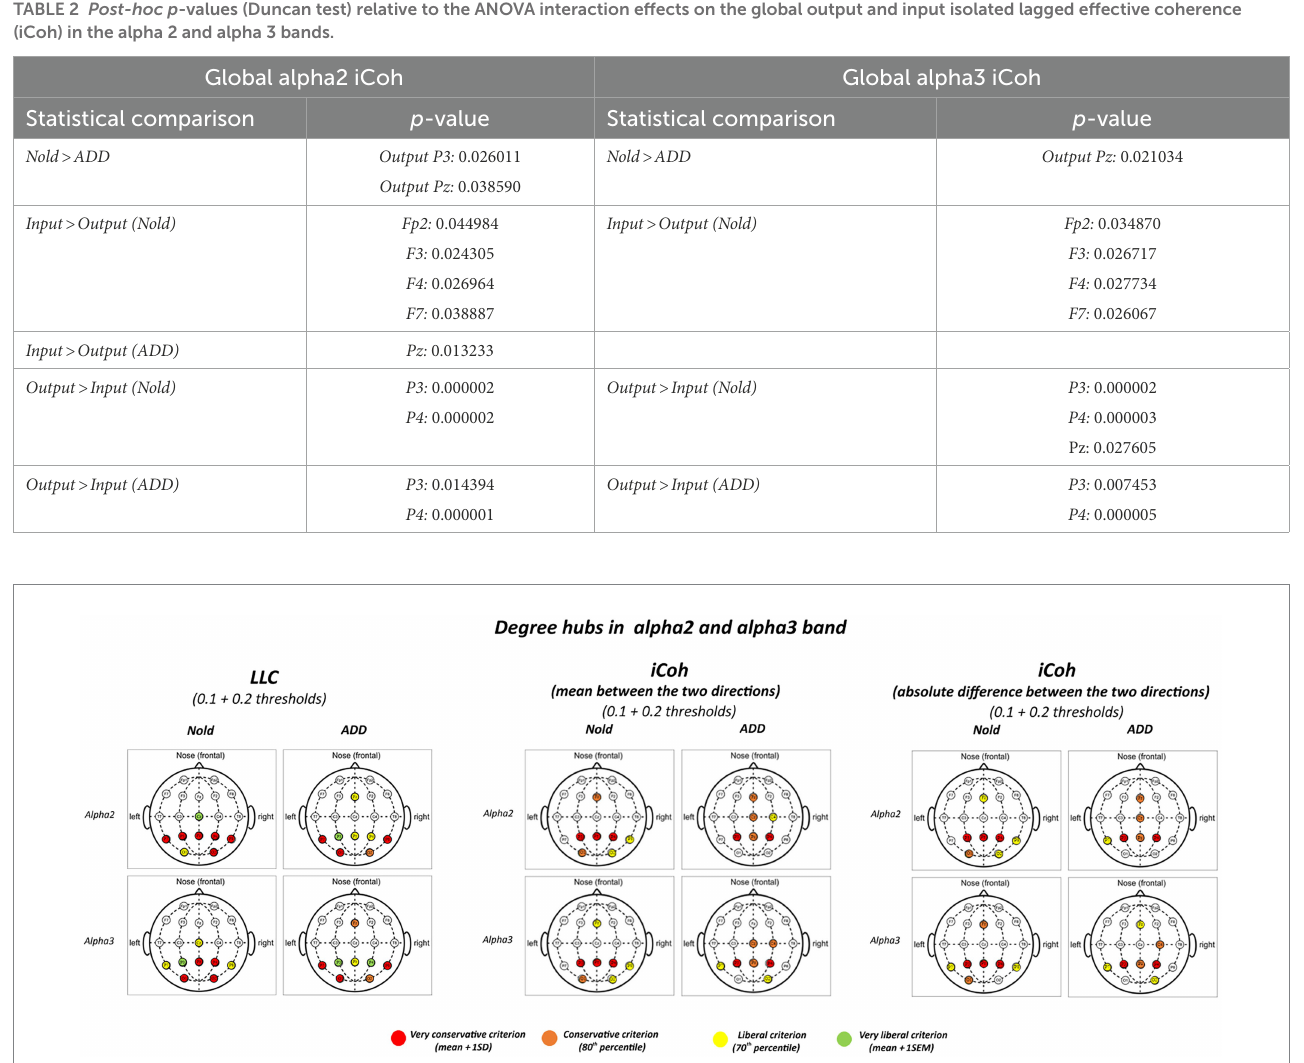
FIGURE 2 Degree hubs for the alpha 2 and alpha 3 linear lagged connectivity (LLC, left column), mean (middle column), and absolute difference isolated lagged effective coherence (iCoh, right column) values in the Nold and ADD groups defined according to nodal degree (ND) calculated at 0.1 and 0.2 graph thresholds. Colors correspond to the different criteria adopted (mean and SD, 80th percentile, 70th percentile, mean and